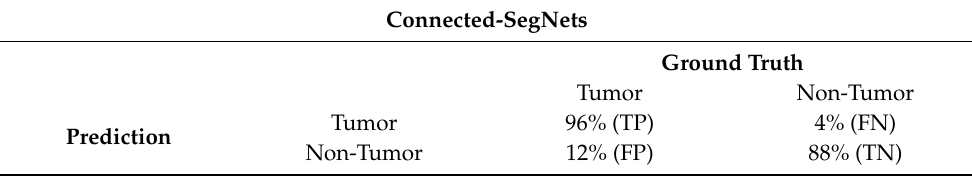
Table 4. Confusion matrix results of the proposed Connected-SegNets on INbreast dataset.